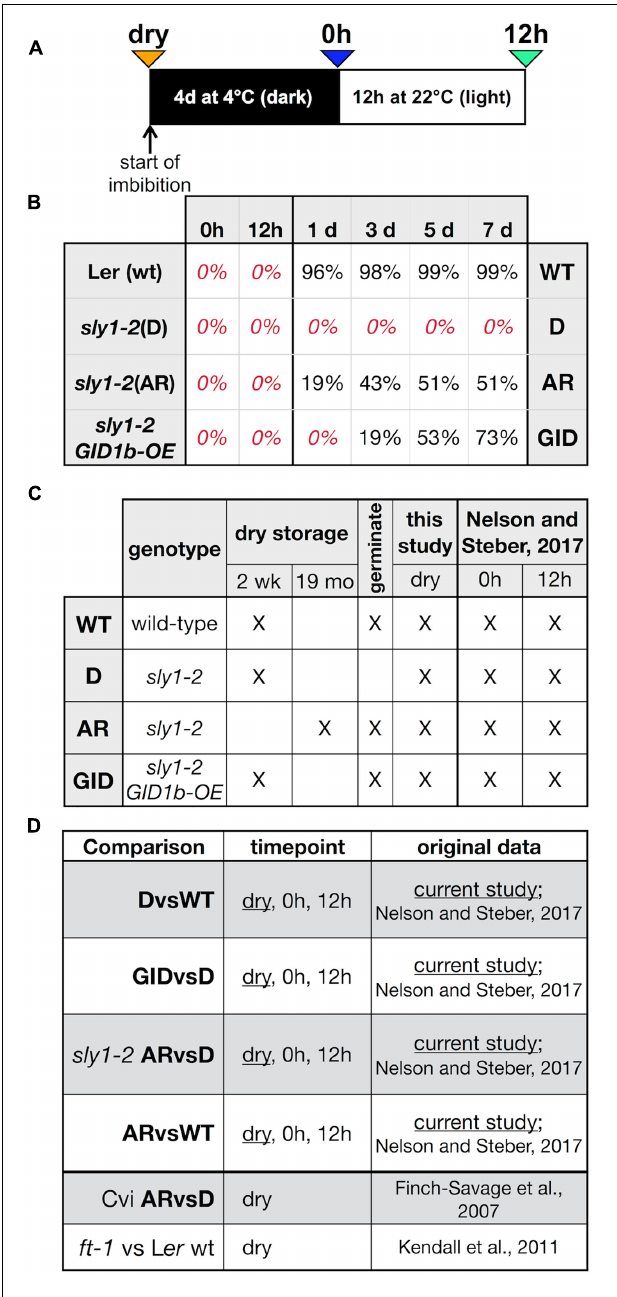
FIGURE 1 | Microarray experimental design. (A) Seeds in this study were examined at the “dry” (orange) timepoint in dry seeds. Comparisons were also made to Nelson and Steber (2017) “0h” (blue) timepoint after cold stratification in the dark for 4 days at 4 ◦ C and the “12h” (green) timepoint with cold stratification and 12h in the light at 22 ◦ C. (B) Germination of seeds used for microarray analysis. The same batches of seeds as in Nelson and Steber (2017) were imbibed on MS-agar plates for 4 days at 4 ◦ C, then moved to the light at 22 ◦ C and scored for germination. (C) L er wt, sly1-2 (D), and sly1-2 GID1b-OE seed batches were 2 weeks old, while sly1-2 (AR) was 19 months old seed. (D) Experimental comparisons made in this paper, including comparisons from reanalysis of data from Finch-Savage et al. (2007) and Kendall et al.